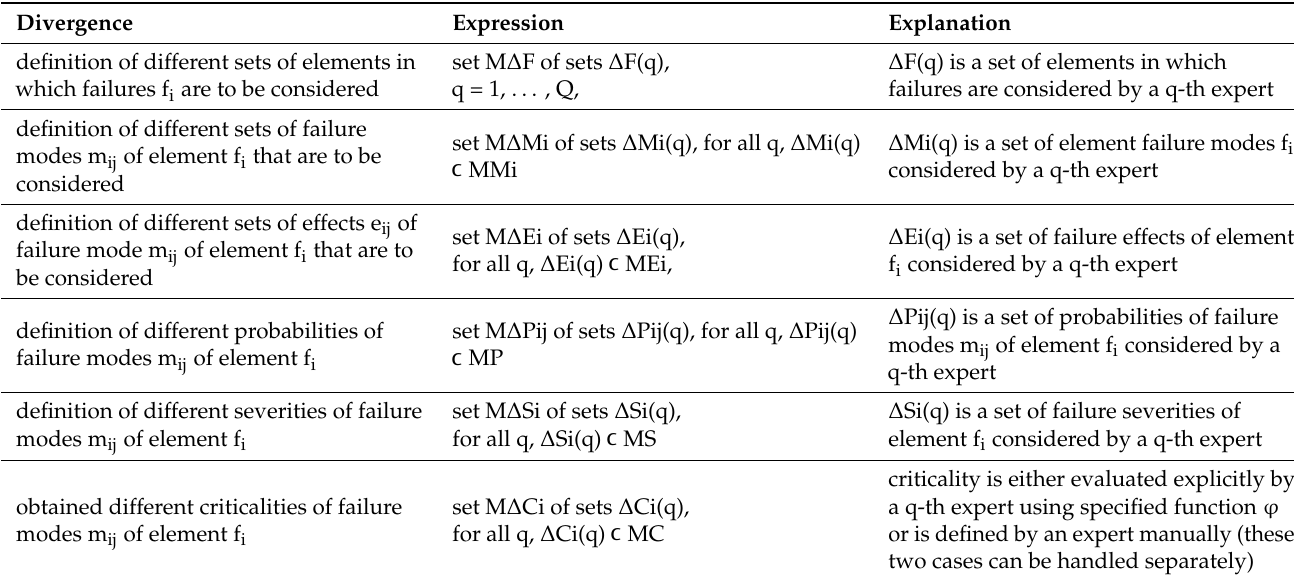
Table 3. Divergences for a group of experts.